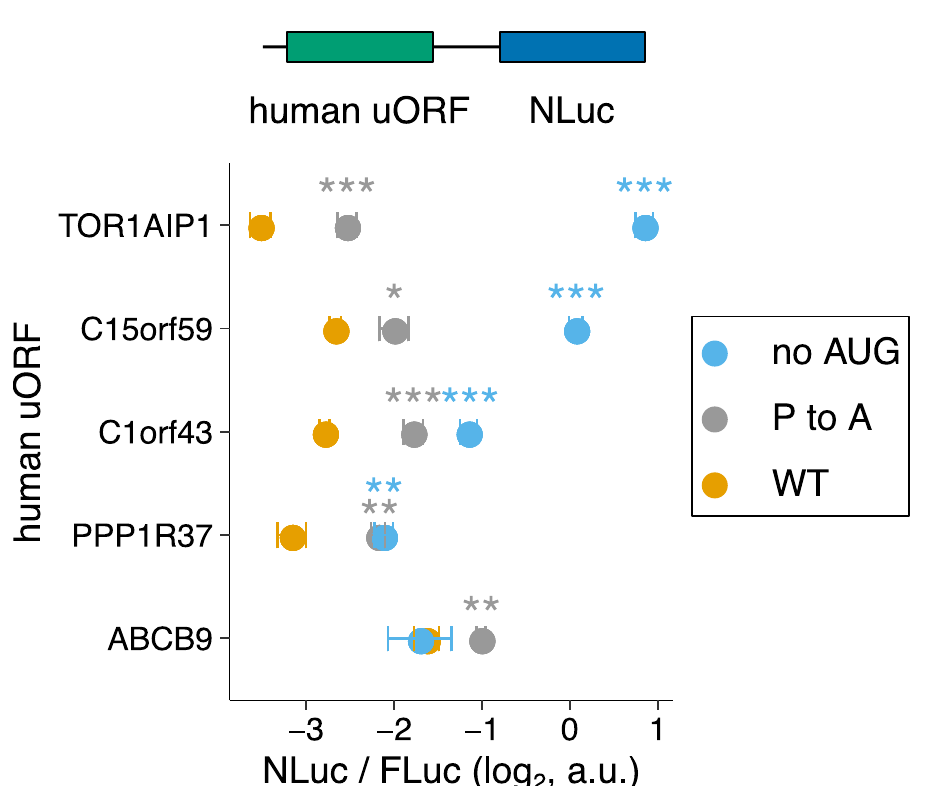
Fig 7. Several human uORFs have repressive terminal diproline motifs. Terminal diproline motif-containing human uORFs are used in the dual-luciferase assay (Fig 2B). The terminal proline codon in each uORF is mutated to an alanine codon in the P to A mutant. Start codons are mutated to ACC for the no-AUG mutants. P values comparing the indicated mutants to the wild-type are from a two sample t-test: � (0.01 < P < 0.05), �� (0.001 < P < 0.01), ��� (P < 0.001). Error bars show standard error of mean NLuc / FLuc ratios over 5 biological replicates. Data are normalized to a no- UL4 -uORF2 start codon